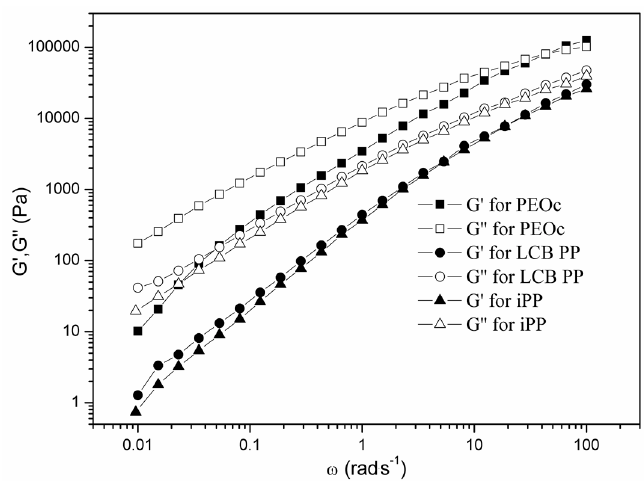
Figure 12. The frequency dependence of G’ and G” for the neat iPP, LCB PP and PEOc at 180 °C. Table 2. Estimated values of the parameters of the Palierne model for iPP/PEOc and LCB PP/PEOc blends at 180 °C. Sample ϕ